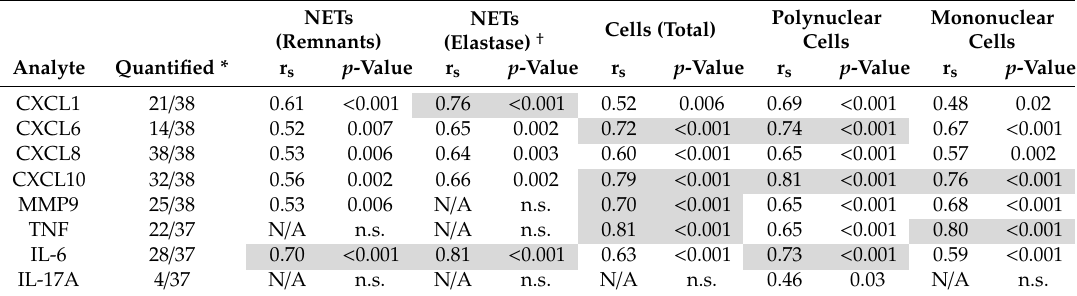
Table 3. Spearman’s correlation between cytokines, chemokines, cells and NETs in CSF. NETs (Remnants)